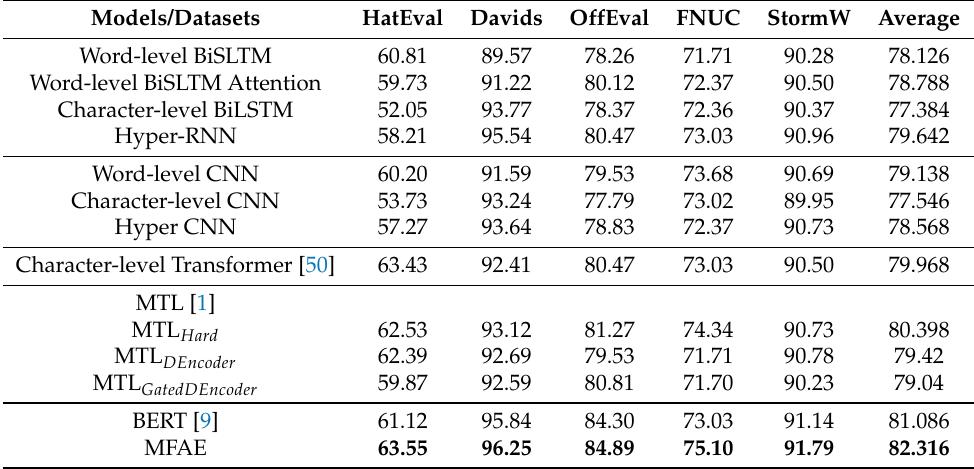
Table 4. Accuracy score (%) for different models on five datasets. The optimal results are indicated in